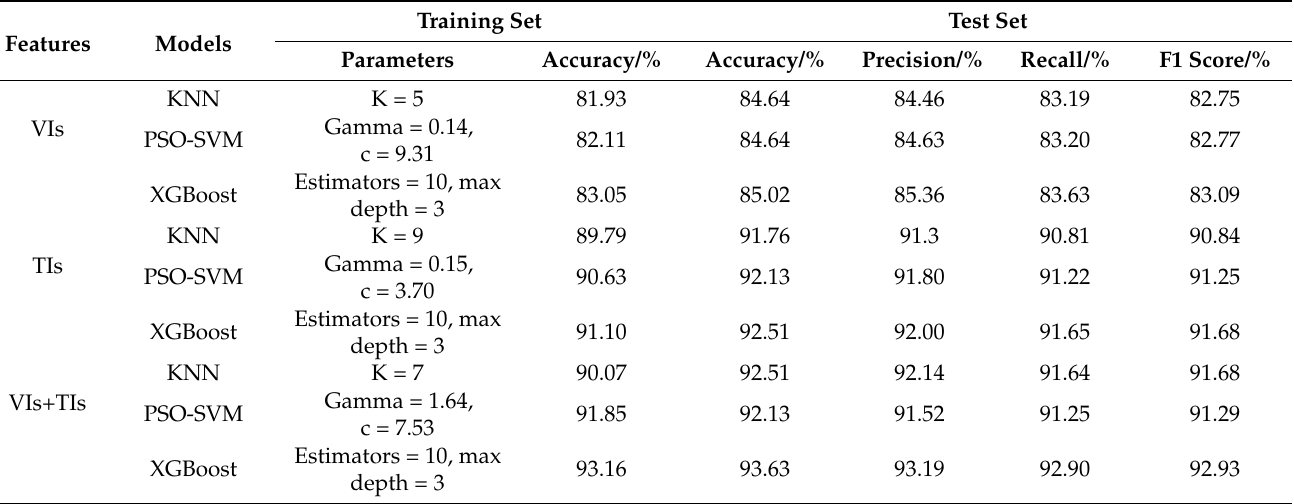
Table 4. Evaluation metrics of wheat FHB monitoring